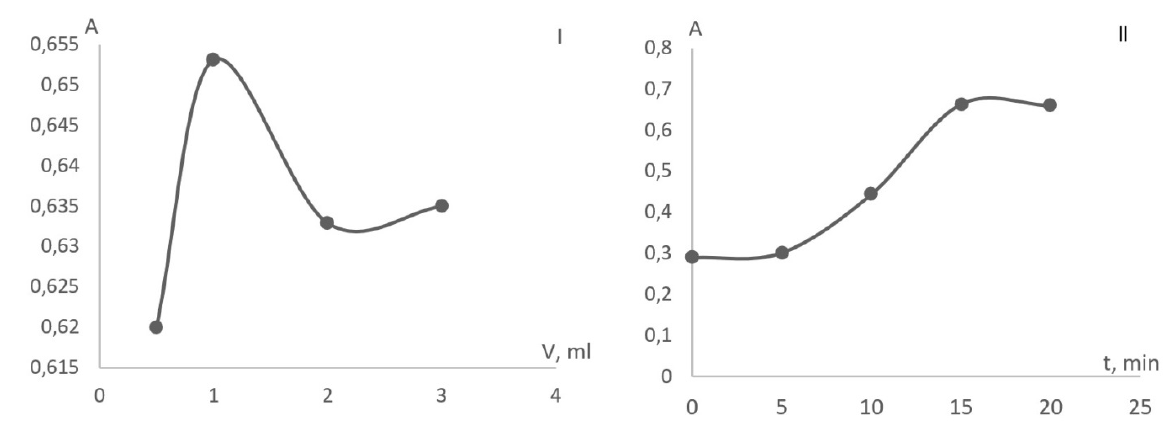
Fig. 2. I – Dependence of optical density on the amount of 0.070 % solution of diazole red 2J; II – on the time of keeping the reaction mixture at room temperature